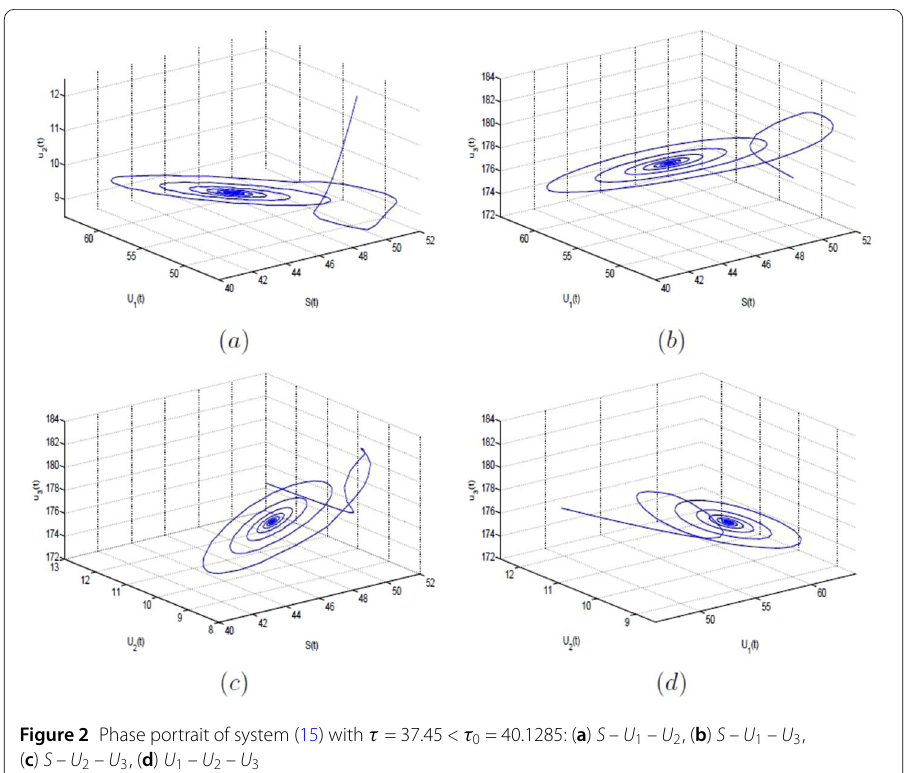
Figure 2 Phase portrait of system (15) with τ = 37.45 < τ 0 = 40.1285: ( a ) S – U 1 – U 2 , ( b ) S – U 1 – U 3 , ( c ) S – U